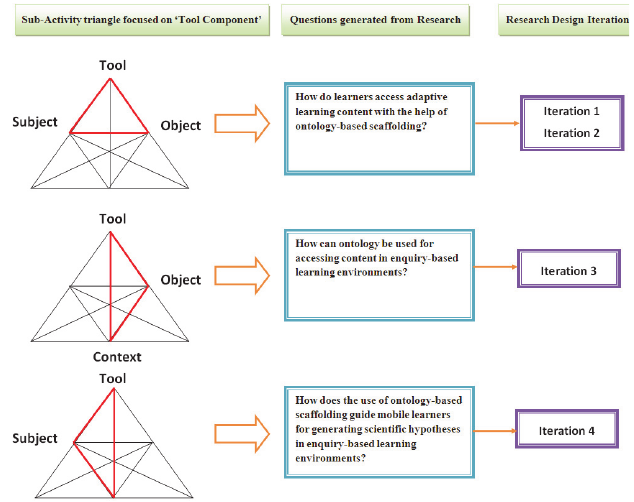
Figure 3 . Mapping AODM operational processes with design